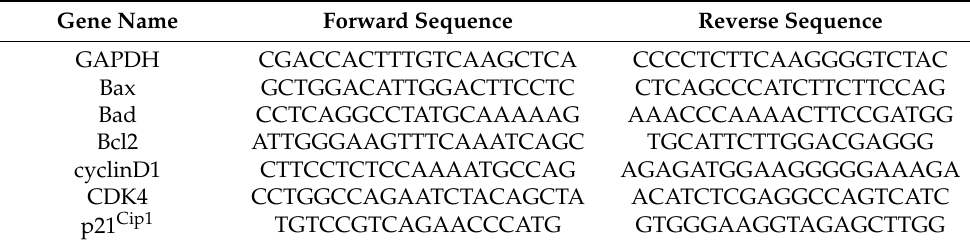
Table 1. List of primer sequences used during the